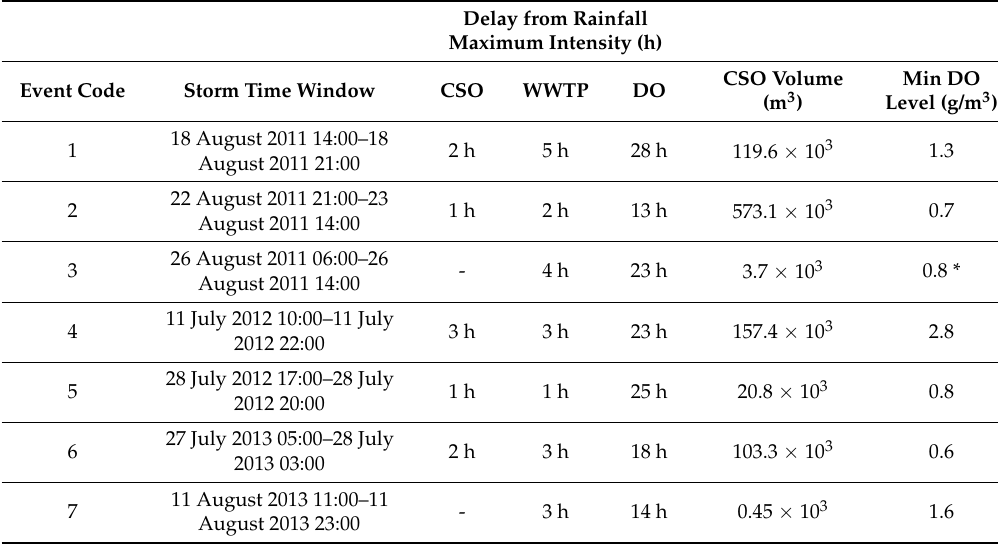
Table 2. Characteristic time scales. Calculated as the delay time between the main rainfall peak and the maximum discharge for; (1) the sum of combined sewer overflows (CSO); (2) the time to reach maximum flow capacity at the treatment works (WWTP) and (3) the time of stabilisation of the dissolved oxygen minimum river level (DO, measured ~17 km downstream of the